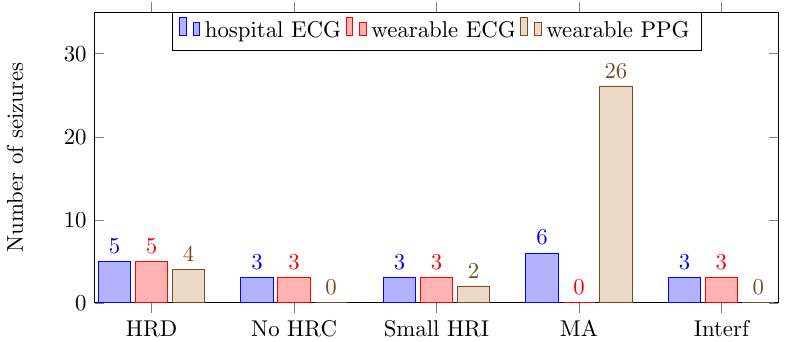
Figure 4. Number of and reason for missed seizures (HRD: heart rate decrease; No HRC: no heart rate change; Small HRI: small heart rate increase: MA: notion artifacts; Interf: